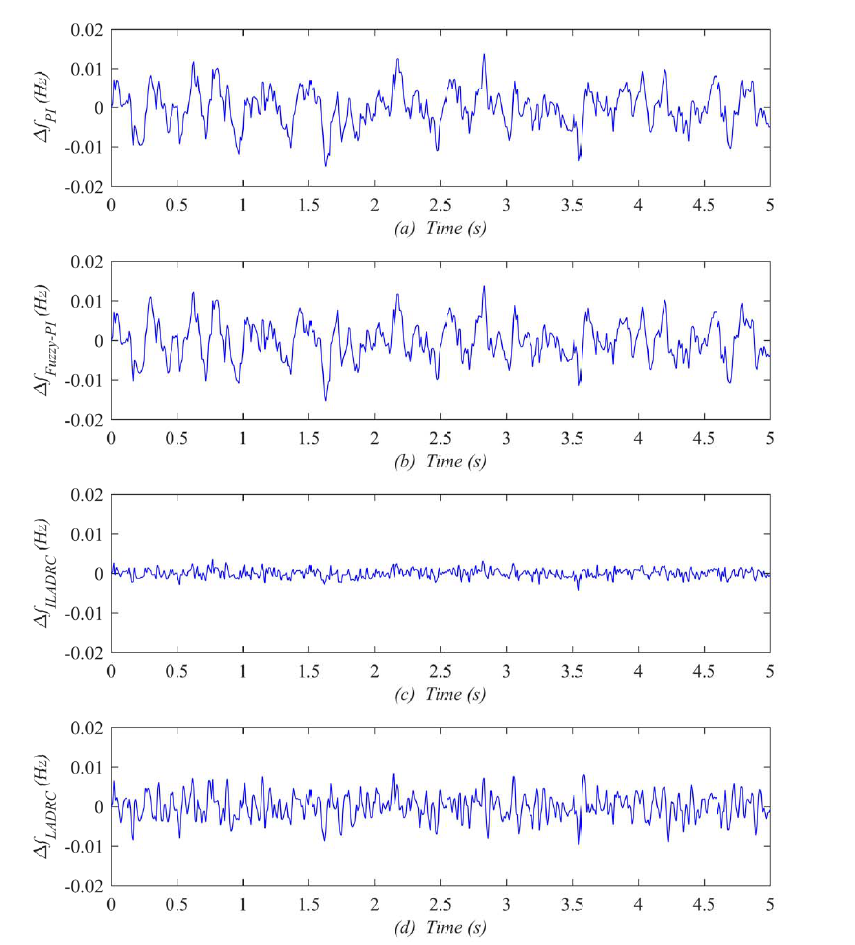
Figure 15. Transient response of system frequency deviation under stochastic power output of wind turbine generator. ( a ) Frequency deviation with PI controller; ( b ) Frequency deviation with Fuzzy-PI controller; ( c ) Frequency deviation with ILADRC controller; ( d ) Frequency deviation with LADRC